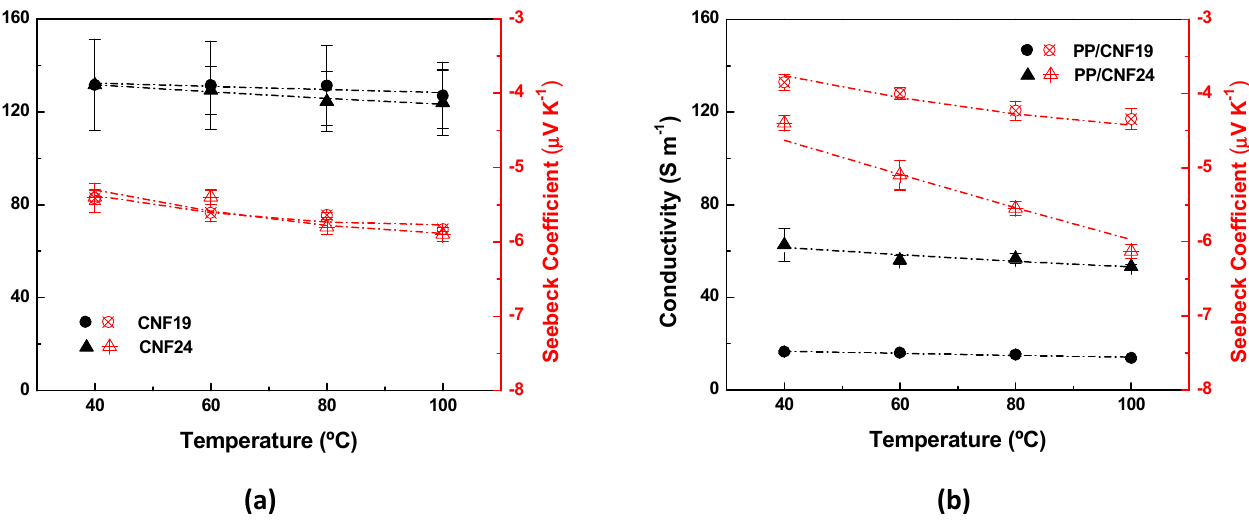
Figure 7. Electrical volume conductivity (black symbols) and Seebeck coefficient (red symbols): ( a ) σ and S of CNFs, ( b ) σ and S of PP/CNF composites. The black and red dash lines represent the fitting with Equations (2) and (3), respectively. (Data for CNF19 and PP/CNF19 taken with permission from ref. [15]. Data of CNF 24 taken with permission from ref. [21]).